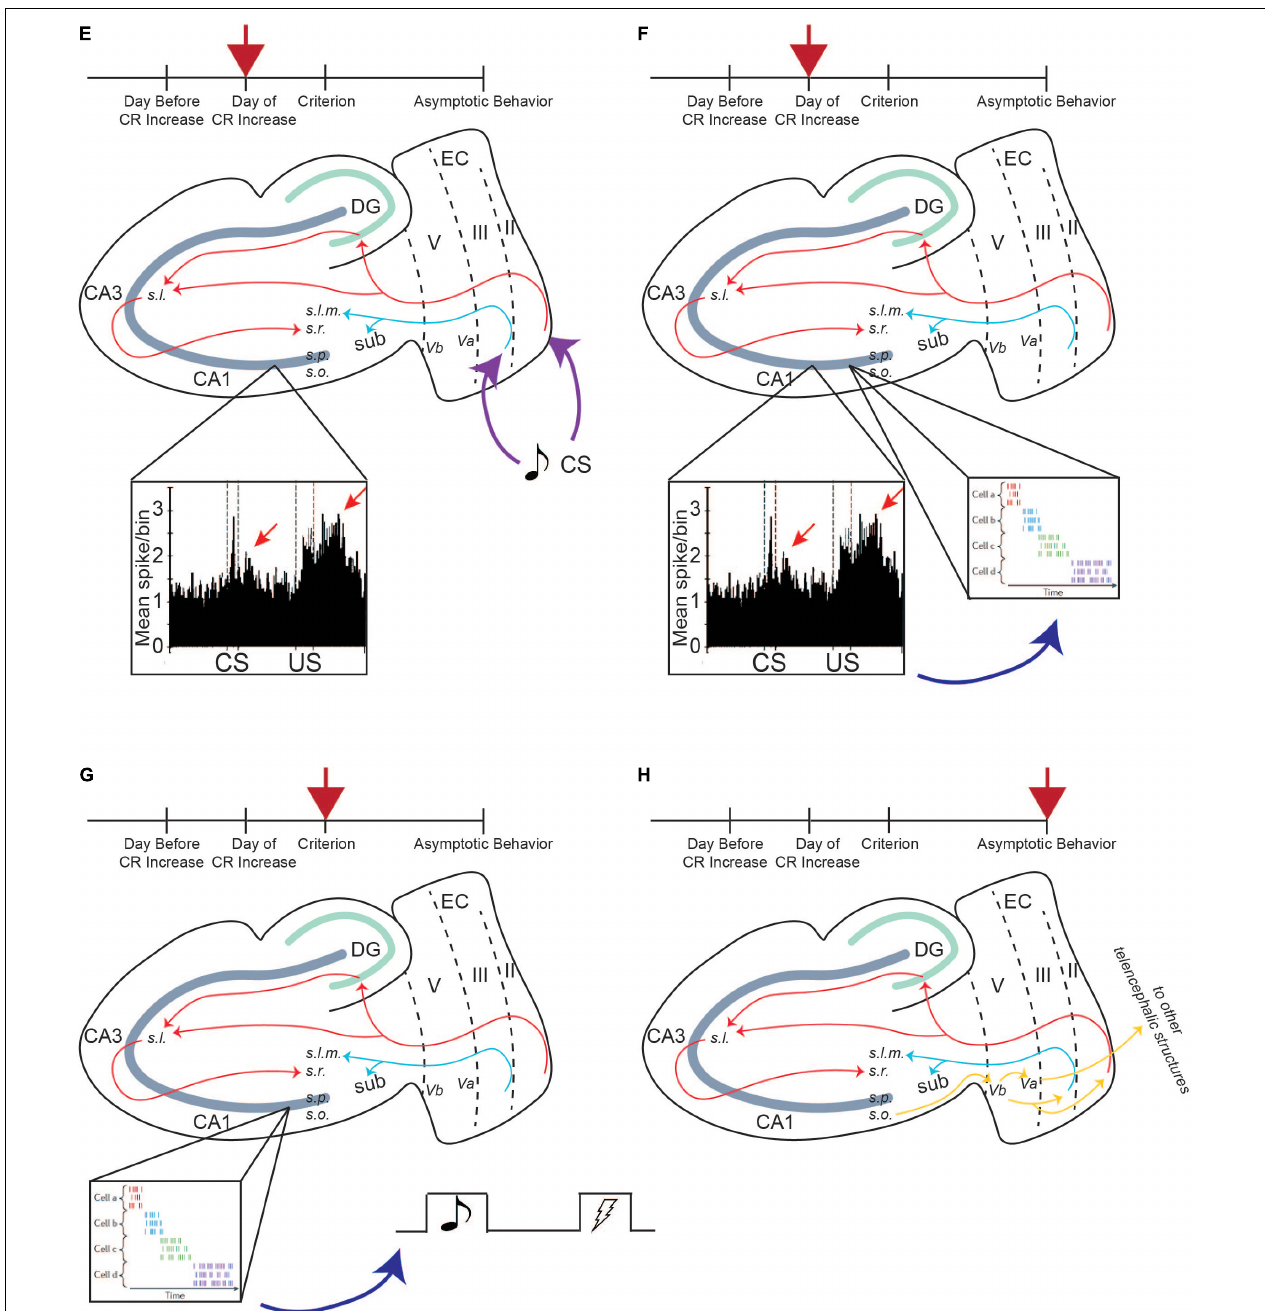
FIGURE 5 | Persistent firing enhances input to CA1 pyramidal neurons, allowing for successful learning. Red arrow indicates timepoint in training. The day before CR increase, CA1 encodes the saliency of US, and activity increases in response to US (A) , inset, enhanced CA1 activity to US presentation, adapted from McEchron and Disterhoft (1999). Enhanced CA1 activity feeds back to LEC III and decreases the AHP, increasing the excitability of these neurons (B) , which allows it to persistently fire more easily. Incoming CS information can activate persistent firing in LEC III (C) , inset, persistent firing). Persistent firing can enhance SC input containing CS information, which is being projected to the CA1 region via the PF path (D) , inset, TA firing enhances SC input to CA1 neurons, adapted from Remondes and Schuman (2002). CA1 neurons increase their activity in response to CS presentation (E) , inset, enhanced CA1 activity to CS and US presentation, adapted from McEchron and Disterhoft (1999). Enhanced CA1 activity to the stimuli can drive sequential time-locking in time cells (F) , inset, time cell activity, adapted from Eichenbaum (2014). Time-locking encodes CS, trace interval, and US sequence within a single trial, helping the animal bridge the temporal gap between the stimuli, and is stabilized when the animal reaches a criterion for learning (i.e., when the animal exhibits consistent CRs) (G) . Once the animal learns the paradigm well and reaches asymptotic behavior, the behavior is moved out of the hippocampus via output pathways to be consolidated into long-term memory (H) . From Lin